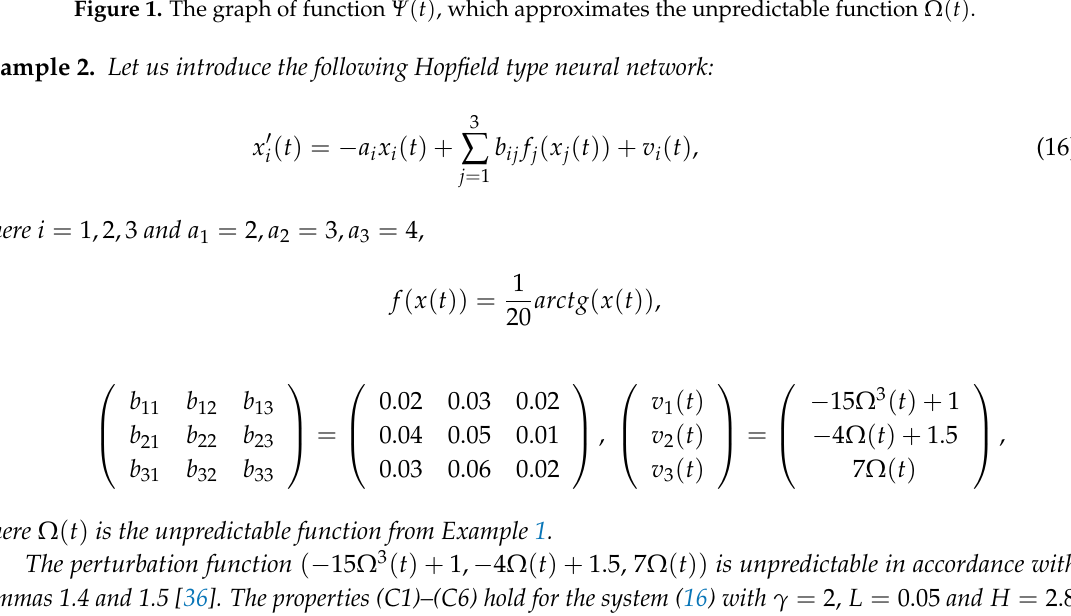
Figure 1. The graph of function Ψ ( t ) , which approximates the unpredictable function Ω ( t )